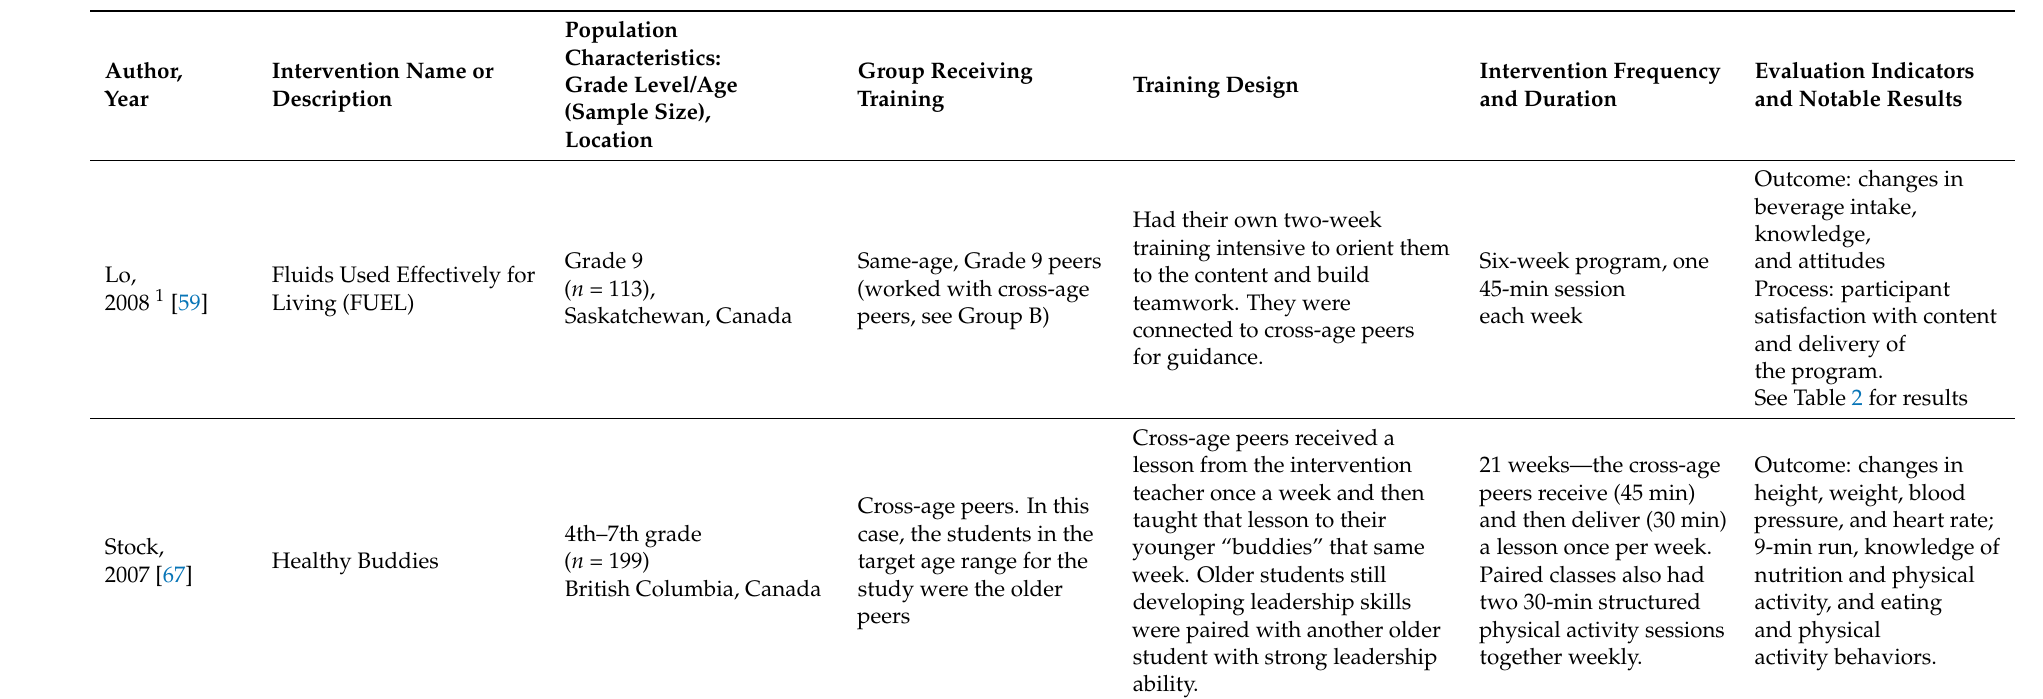
Table 4. Group C: Classroom-based interventions that trained same-age